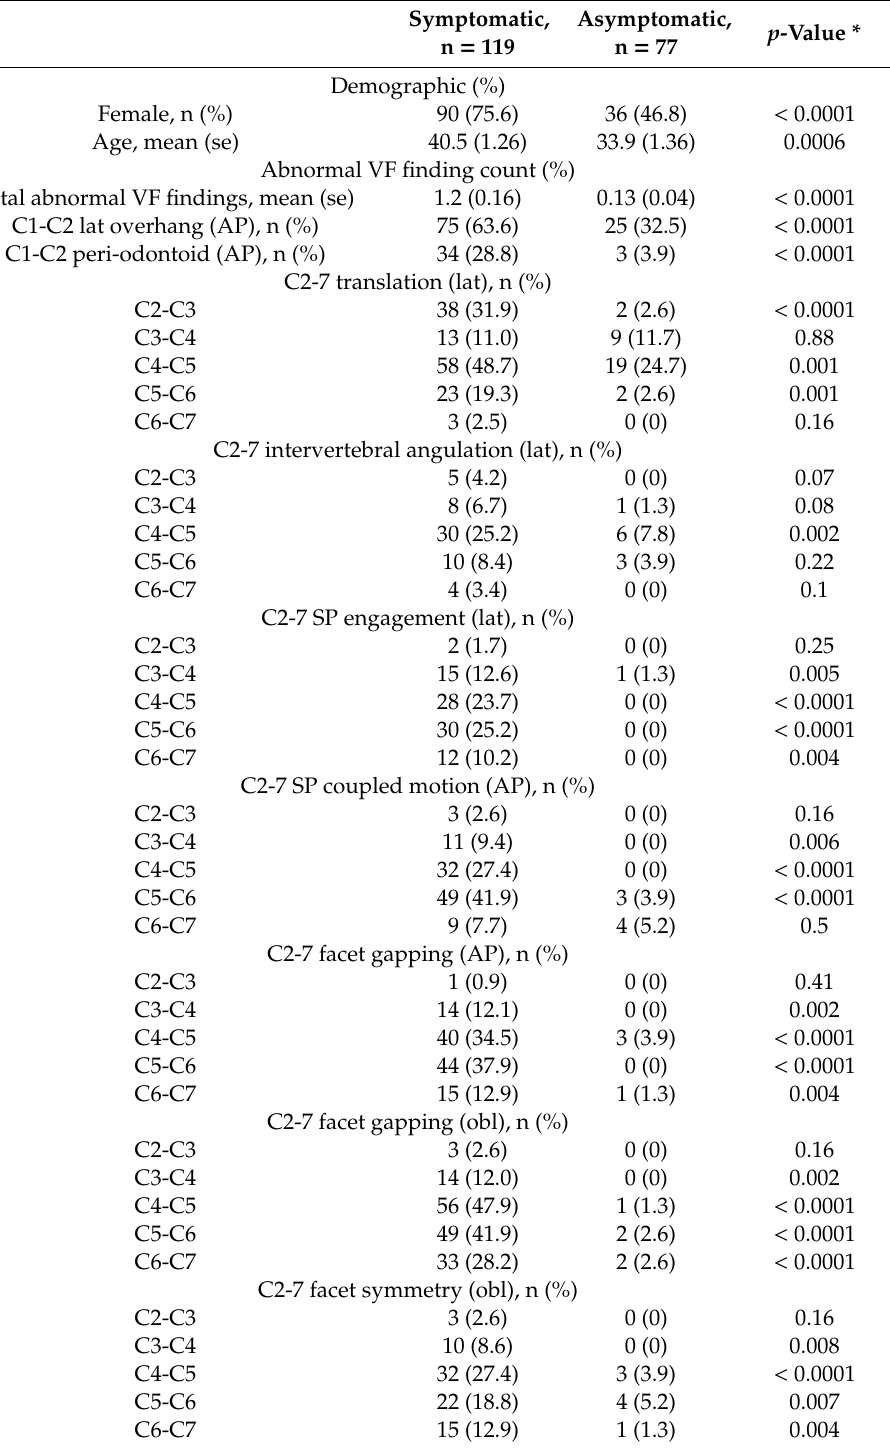
Table 3. Crude associations between injured and uninjured groups.